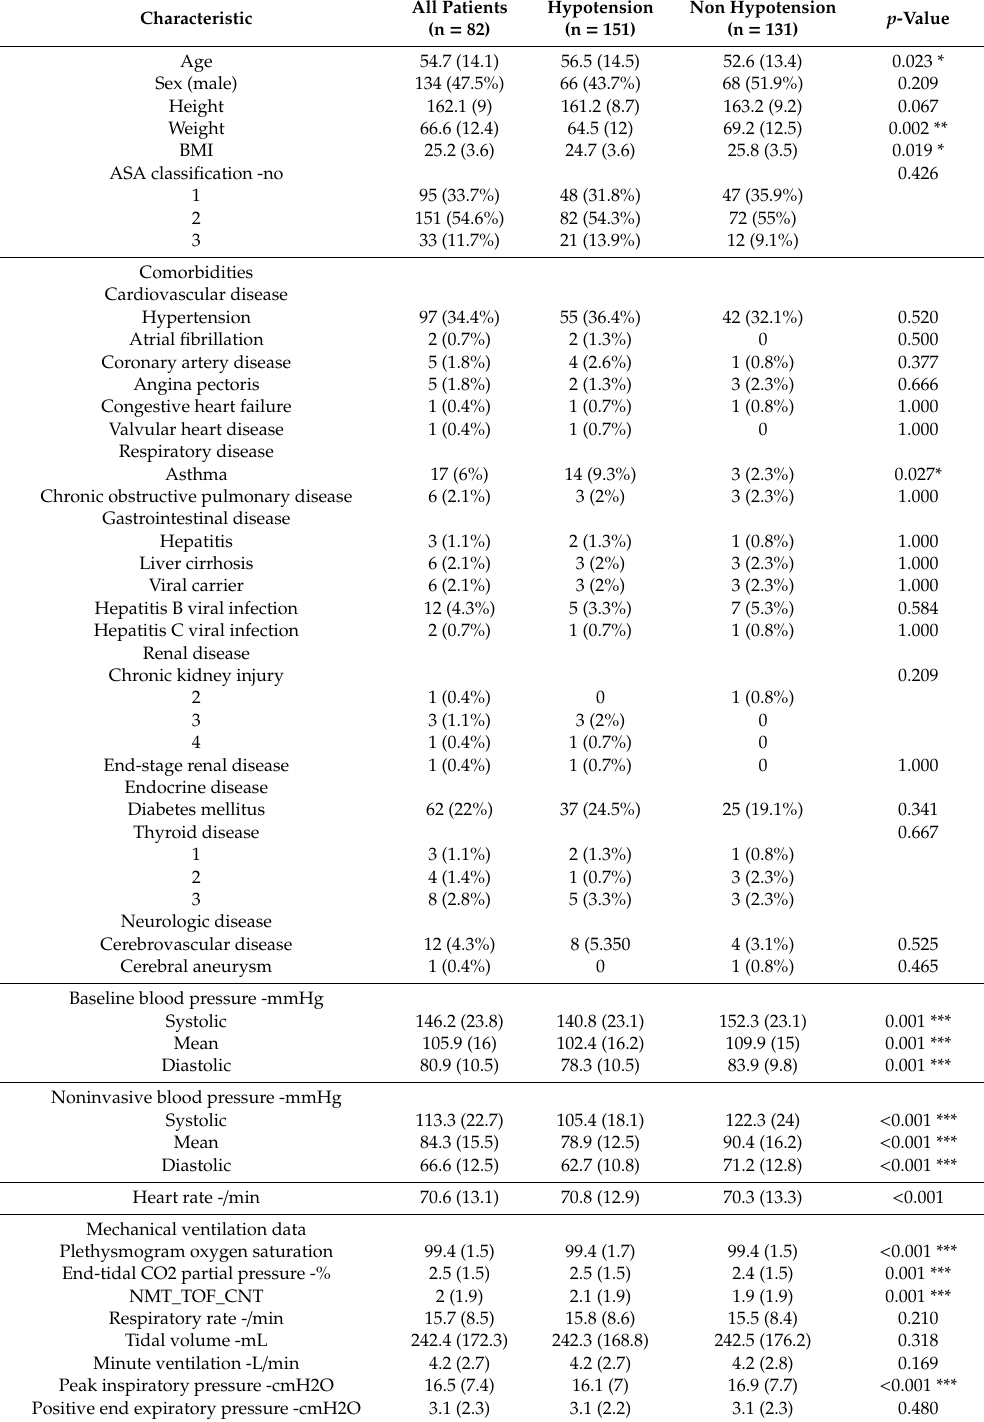
Table 3. Patient